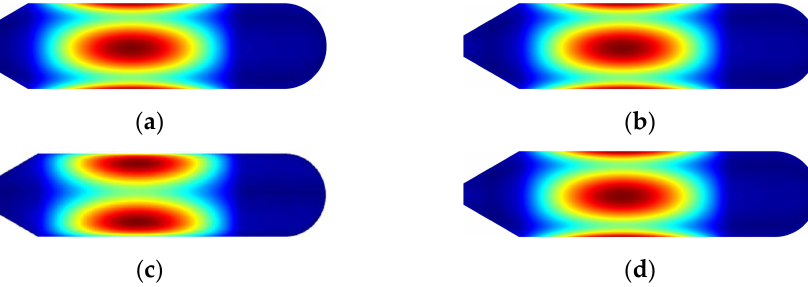
Figure 7. The first mode shapes with L 1 = 5 m and h 2 = 0.15 m. ( a ) Clamped boundary. ( b ) Simply supported boundary. ( c ) Shear–diaphragm boundary. ( d ) Free boundary.